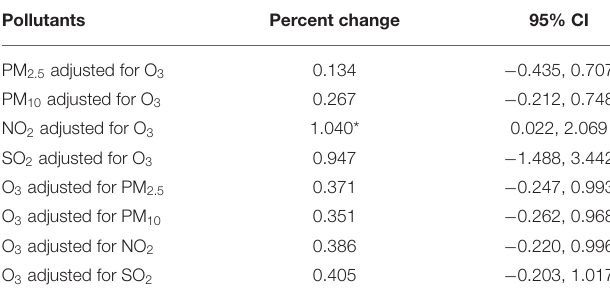
TABLE 4 | Percent changes in daily hospital admissions for ischemic stroke associated with a 10 µ g/m 3 increase in air pollutant concentrations in two-pollutant